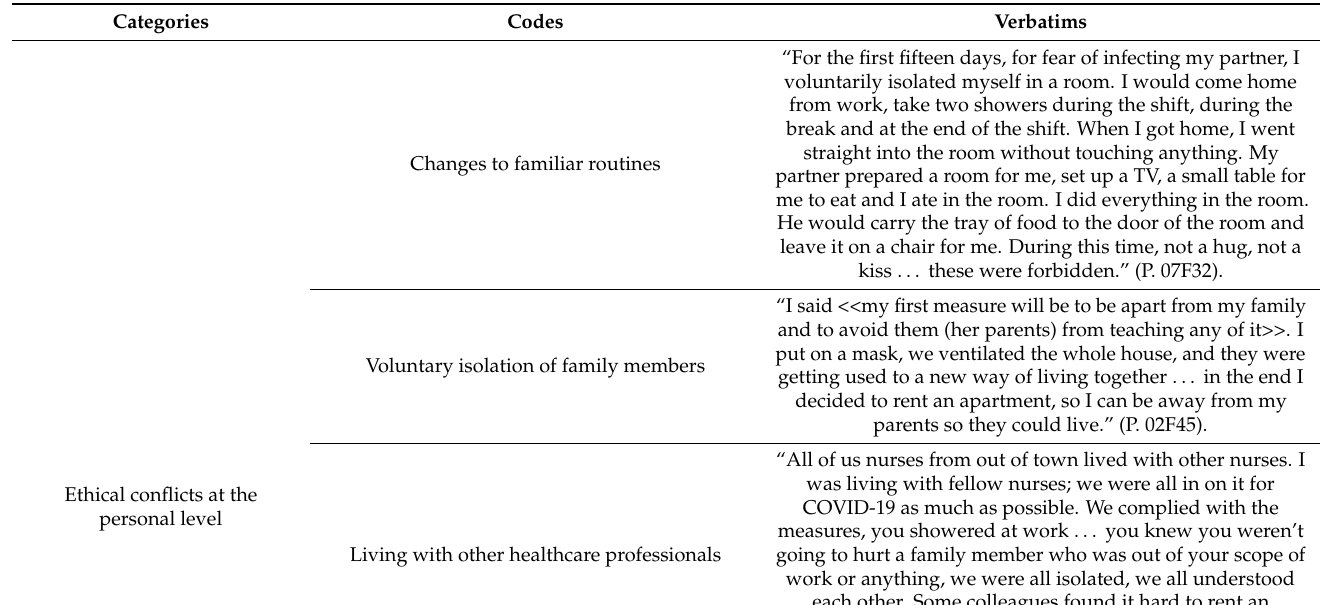
Table 3. Categories, codes, and verbalizations of Theme 1: Ethical conflicts experienced during the